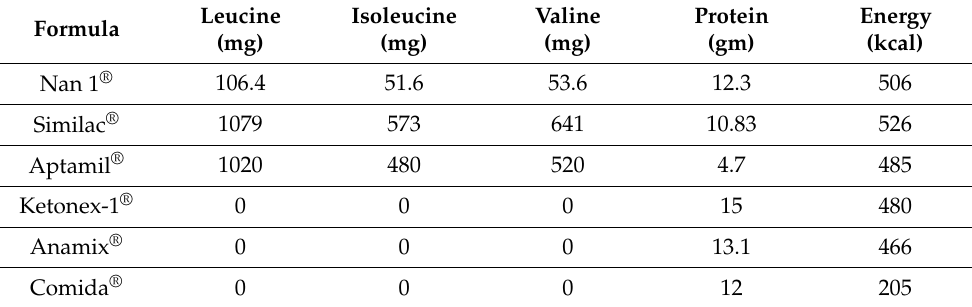
Table 2. Nutrient content of six common